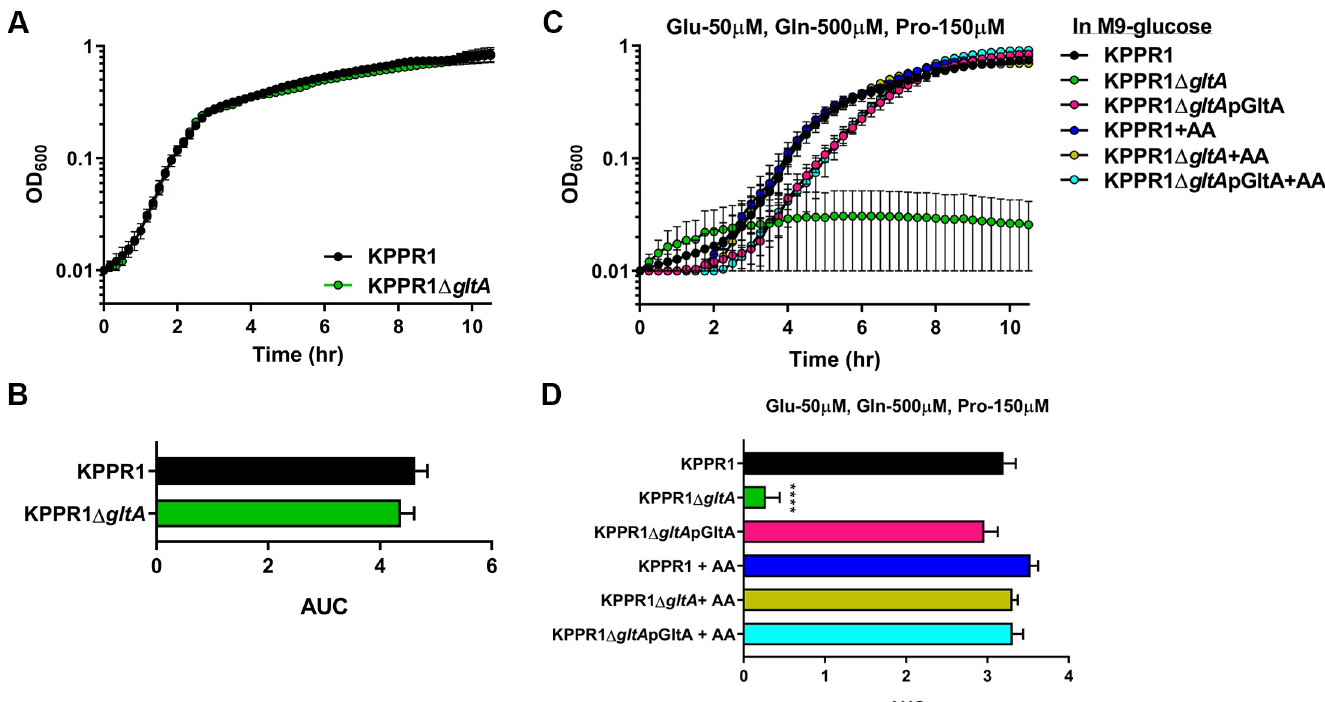
Fig 5. gltA is dispensable for growth in mouse serum. (A) WT KPPR1 and KPPR1 Δ gltA were grown in M9 minimal media + 20% heat-inactivated murine serum without glucose. (B) AUC analysis of WT KPPR1 and KPPR1 Δ gltA growth in M9 minimal media + 20% heat-inactivated murine serum without glucose (n = 3, Student’s t-test, mean displayed ± SEM). (C) WT KPPR1, KPPR1 Δ gltA , and KPPR1 Δ gltA pGltA were grown M9 minimal media + 0.4% glucose with physiological levels of amino acids present in human serum (n = 3, mean displayed ± SEM). (D) AUC analysis of WT KPPR1, KPPR1 Δ gltA , and KPPR1 Δ gltA pGltA growth M9 minimal media + 0.4% glucose with physiological levels of amino acids present in human serum (n = 3, ���� P < 0.00005 compared to all other groups, Tukey’s multiple comparison test following ANOVA, mean displayed ± SEM). “+AA” label indicates addition of amino acids to growth media at concentrations indicated in graph